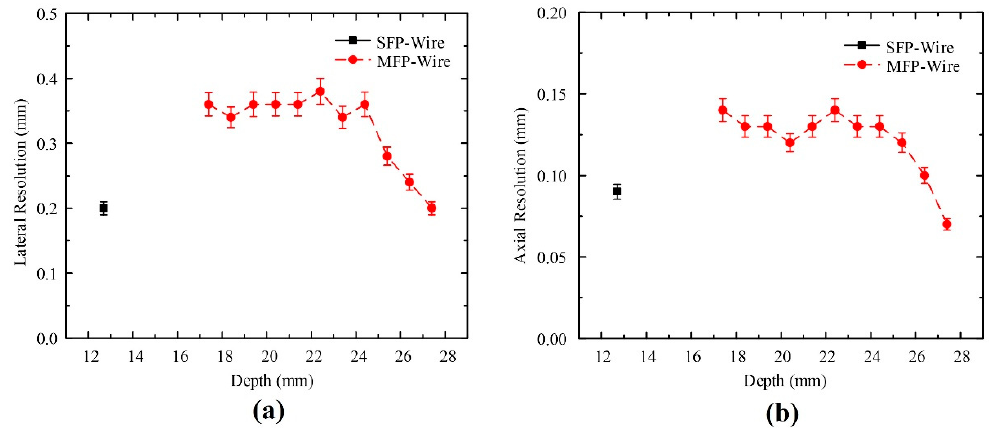
Figure 14. Ultrasound ( a ) lateral and ( b ) axial resolution measurements versus depth in the wire phantoms of the SFP (solid line) and MFP (dashed line) transducers. Error bars denote 95% confidence.